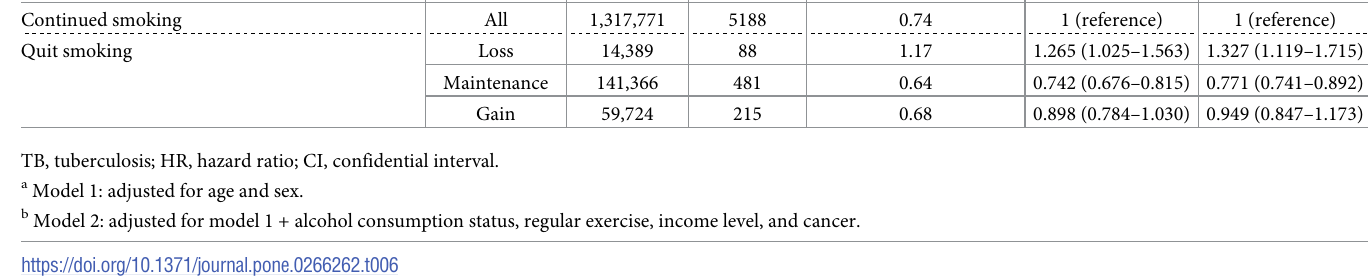
Table 6. Incidence and risk of tuberculosis in quit-smoking group according to weight changes compared with all continued-smoking group regardless of weight changes. Current smoker’s smoking status within 2